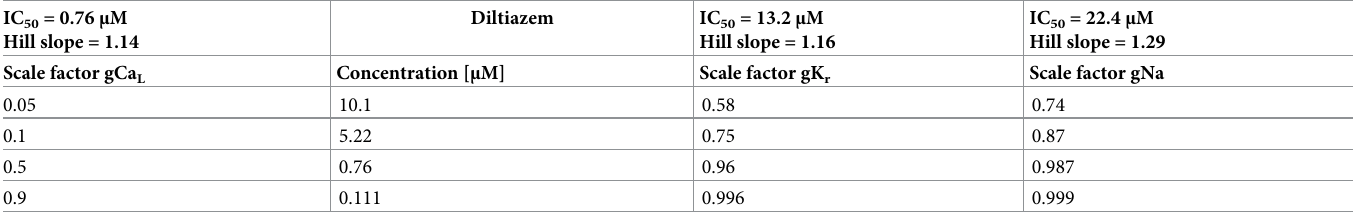
Table 1. Scale factors used to simulate pharmacological manipulation with Diltiazem. IC 50 = 0.76 μ M Hill slope =